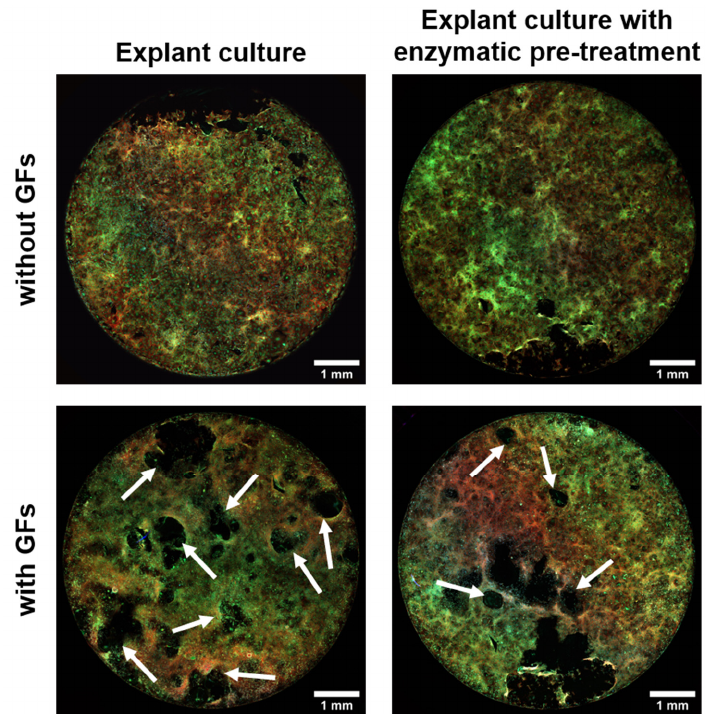
Figure 8. Examples of fluorescent pictures of a whole bottom of a well from which the number of formed rOCs per well, their area, and the number of nuclei per rOC were analyzed. rPBMCs and rOBs isolated either by explant culture or by explant culture with enzymatic pre-treatment were cultured with or without exogenous GFs (M-CSF, RANKL). rOCs were counted only from co-cultures with GFs on day 14. F-actin was stained by Phalloidin-iFluor555 (red), cell membranes were stained by DiOC6(3) (green), and cell nuclei were stained by DAPI (blue). White arrows show examples of the formed rOCs. Magnification 10×, scale bar 1 mm.